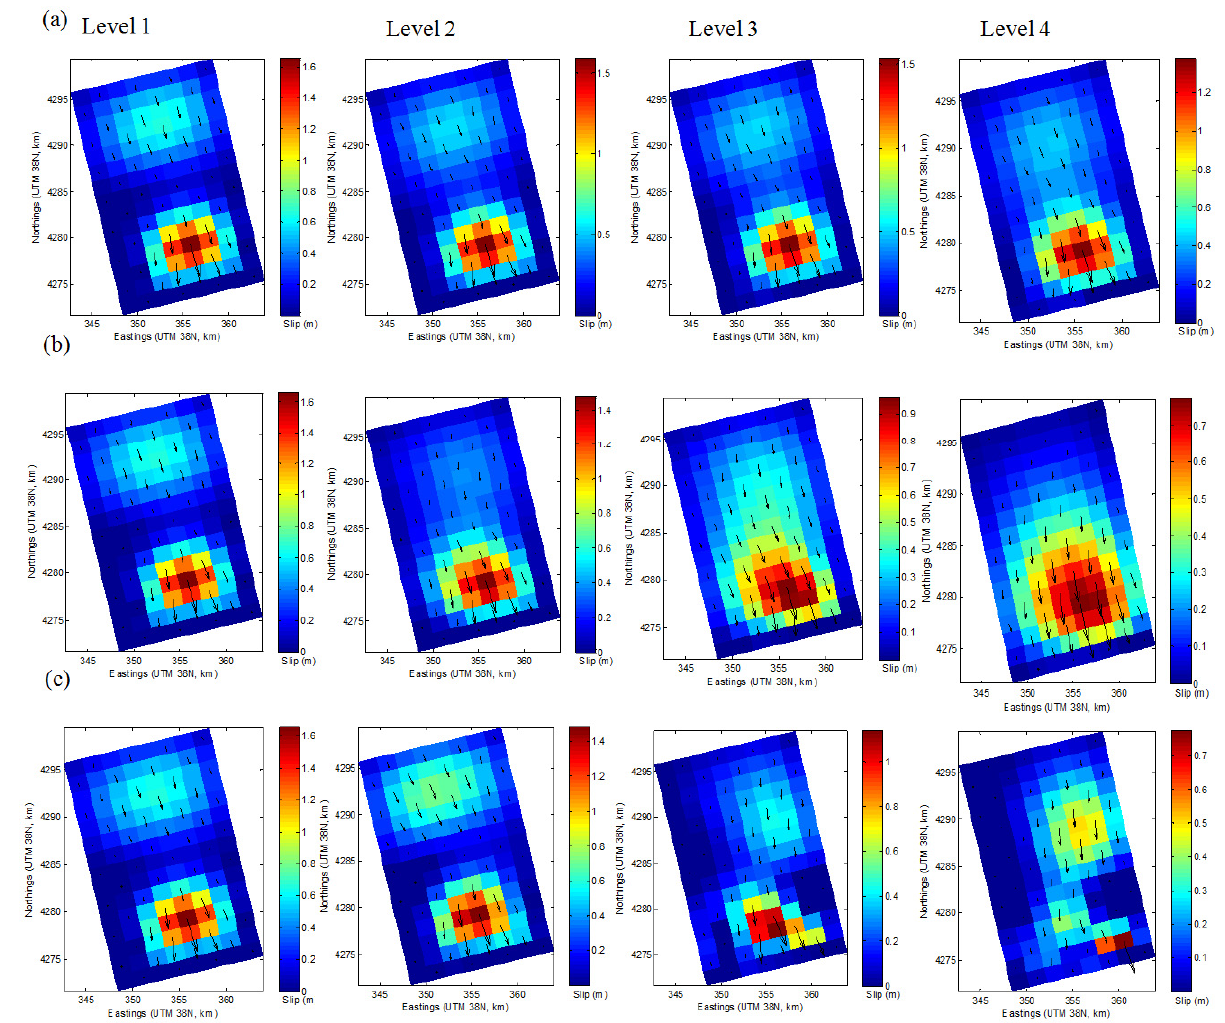
Fig. 3. Slip distribution results from different constraints. Left to right slip distributions correspond to the Level 1 to Level 4 interferograms. (a) Arc constraint. (b) BP constraint. (c) MP